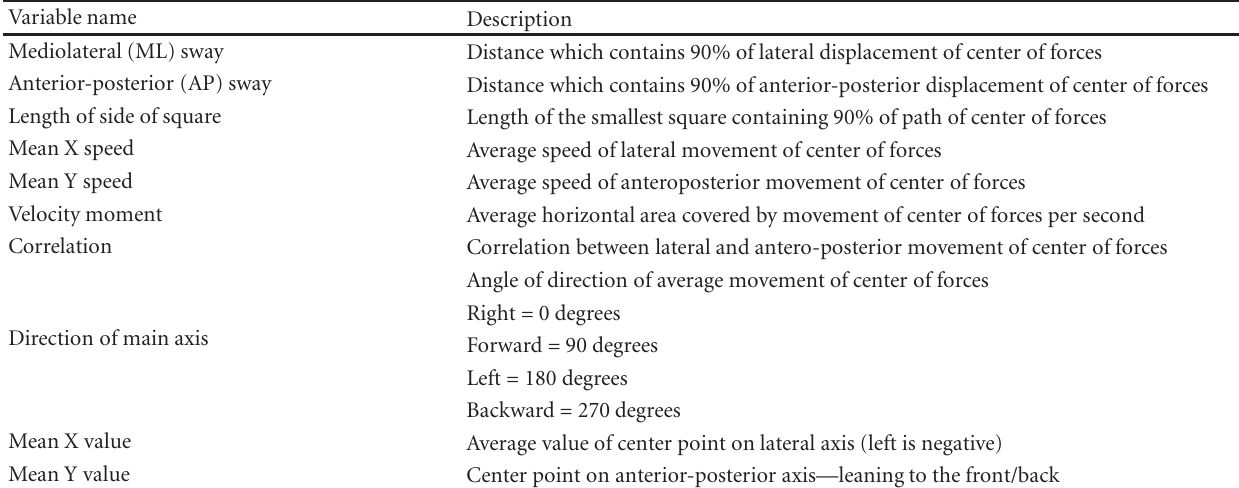
Table 1: Balance platform main variables ( × 4 tests).